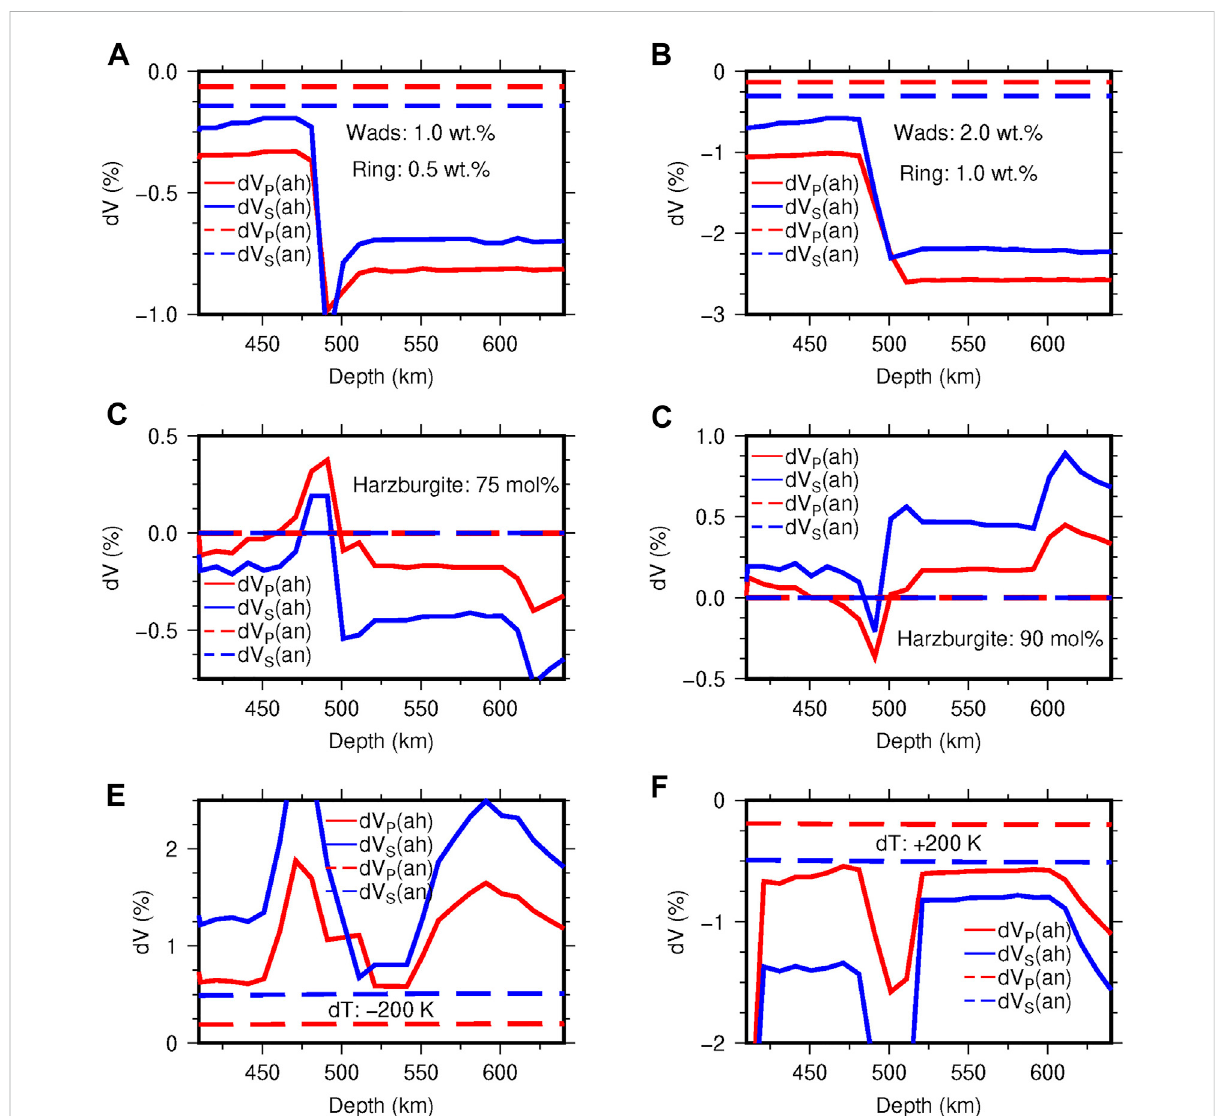
FIGURE 1 Velocity perturbations of (A) a water-unsaturated model (i.e., 1 wt% water in wadsleyite and 0.5 wt% in ringwoodite); (B) a water-saturated model (i.e., 2 wt% water in wadsleyite and 1 wt% in ringwoodite); (C) a depleted harzburgite model (75 mol% harzburgite + 25 mol% basalt); (D) an enriched harzburgite model (90 mol% harzburgite + 10 mol% basalt); (E) a cold model with a temperature 200 K lower than the reference temperature model; (F) a hot model with a temperature 200 K higher than the reference temperature model, relative to velocities of the reference mineral model. Subscripts an and ah represent the velocity anomalies caused by anelastic effect and anharmonic effect